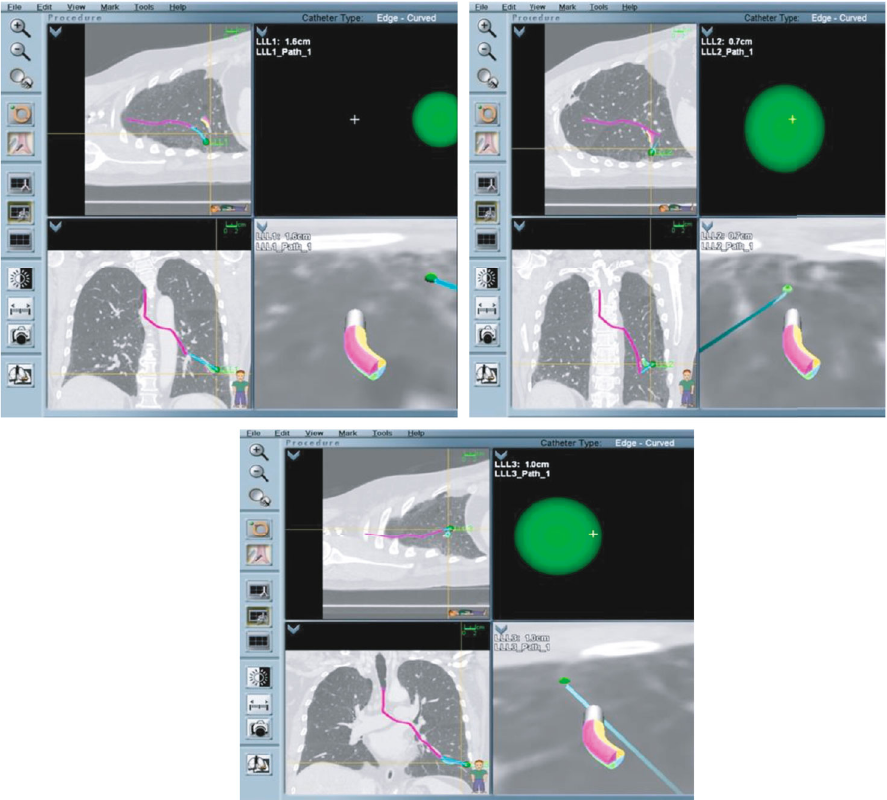
Figure 4: Navigational bronchoscopy on case one. All target areas were reached with the ability to virtually visualize the proximity to the pleural